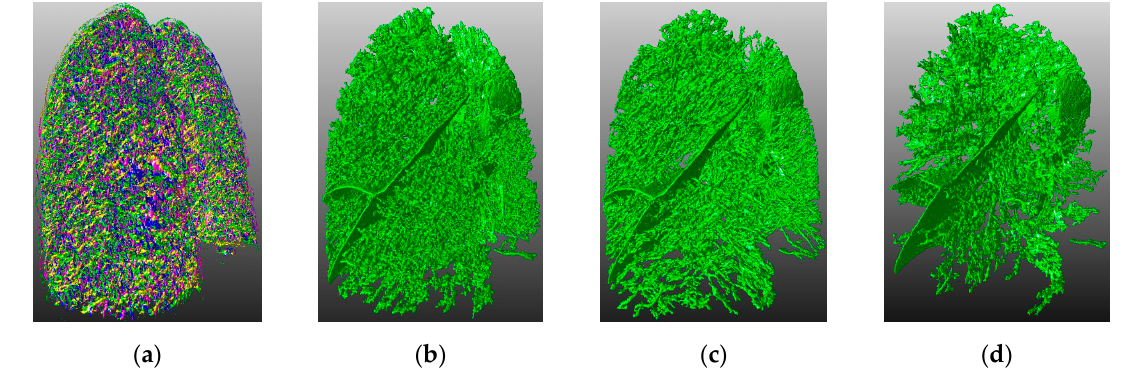
Figure 4. Clutters suppression. ( a ) N i . ( b ) F A . ( c ) F S . ( d ) F C .